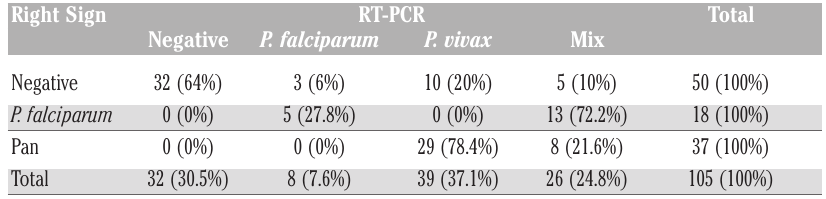
Table 6. Comparison of species detection between RightSign and RT-PCR.